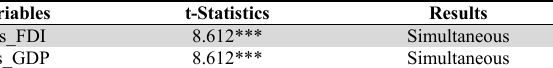
Simultaneous test results